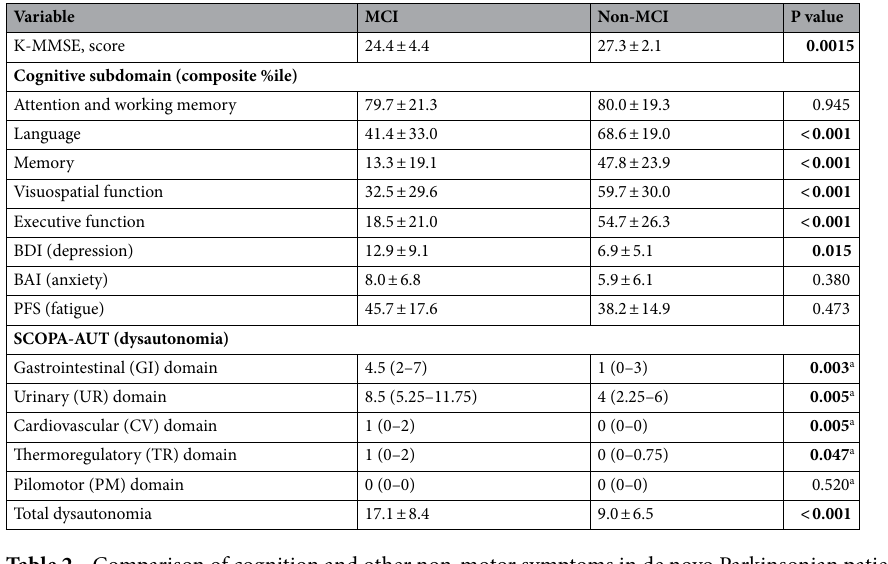
For visuospatial function as shown in Fig. 1C, compared with 45 patients without visuospatial impairment, 15 patients with visuospatial impairment showed higher scores of total motor symptom [median (IQR) of impaired vs. non-impaired: 31 (27.5–37.5) vs. 24 (15.0–30.0); p = 0.0117], HY stage [median (IQR) of impaired vs. non- impaired: 2.5 (2–2.5) vs. 2.0 (2–2.0); p = 0.0074], depression [median (IQR) of impaired vs. non-impaired: 16 the two groups. For executive function as shown in Fig. 1D, compared with 41 patients without executive impairment, 19 patients with executive impairment had higher scores of total motor symptom [median (IQR) of impaired vs. non-impaired: 30 (24.5–37.5) vs. 24 (16.0–31.0); p = 0.0351], HY stage [median (IQR) of impaired vs. non- impaired: 2.5 (2–2.5) vs. 2.0 (2–2.0); p = 0.0101], depression [median (IQR) of impaired vs. non-impaired: 12 (9–19.5) vs. 6 (3–12.0); p = 0.0091], fatigue [median (IQR) of impaired vs. non-impaired: 51 (33.5–64) vs. 41